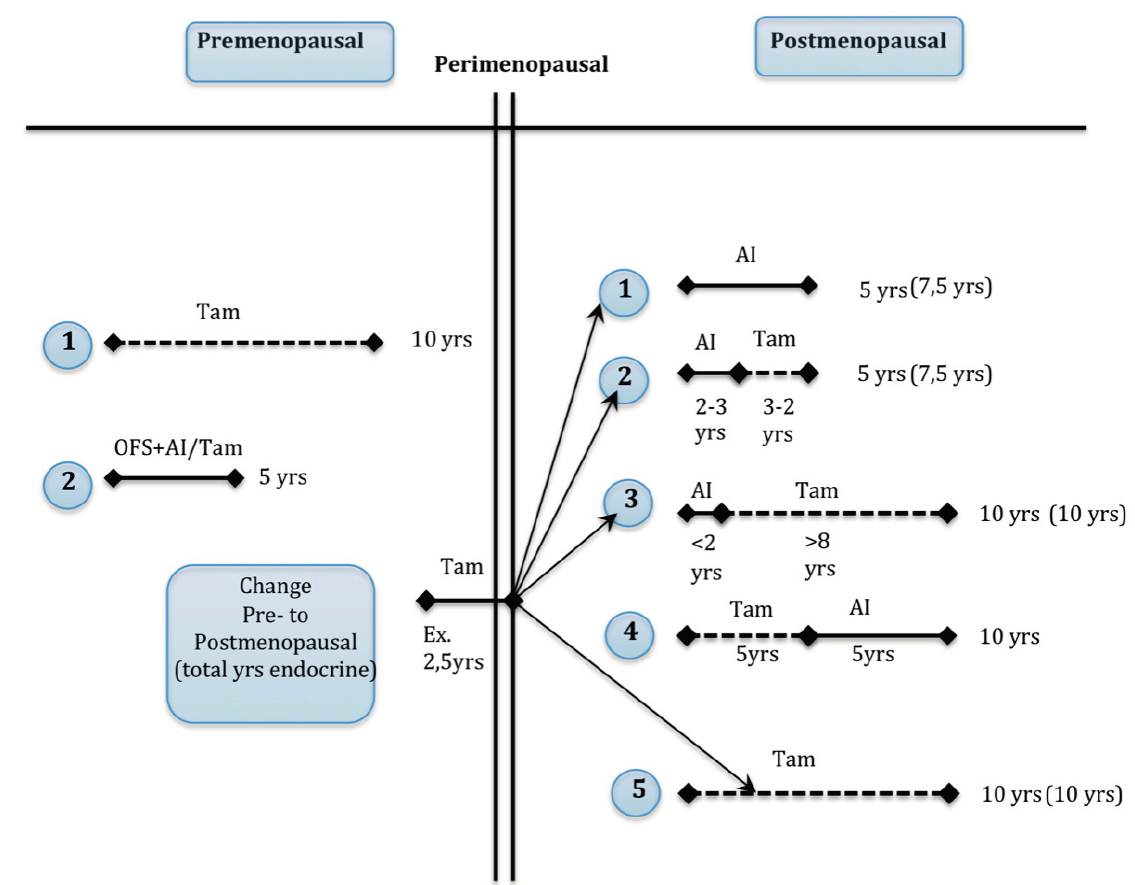
Figure 2. Overview of the adjuvant endocrine treatment guidelines for ER+ breast cancer patients according to the Norwegian Breast Cancer Group (NBCG) 2015 [24], and based on international recommendations (St. Gallen, 2013). There are two options for premenopausal patients (1 and 2 on the left side) and five options for postmenopausal patients (1–5 on the right side) comprising aromatase inhibitor (AI), tamoxifen and ovarian function suppression (OFS) alone or in combination. Total duration of endocrine treatment for a premenopausal patient that becomes postmenopausal after two or five years on tamoxifen (example) is illustrated in brackets. The choice between alternatives 1–5 is made individually based upon tumor biology, side effects and preferences among clinicians and patients. Peri: perimenopausal; TAM: tamoxifen; Yrs: years; Dotted line: years on